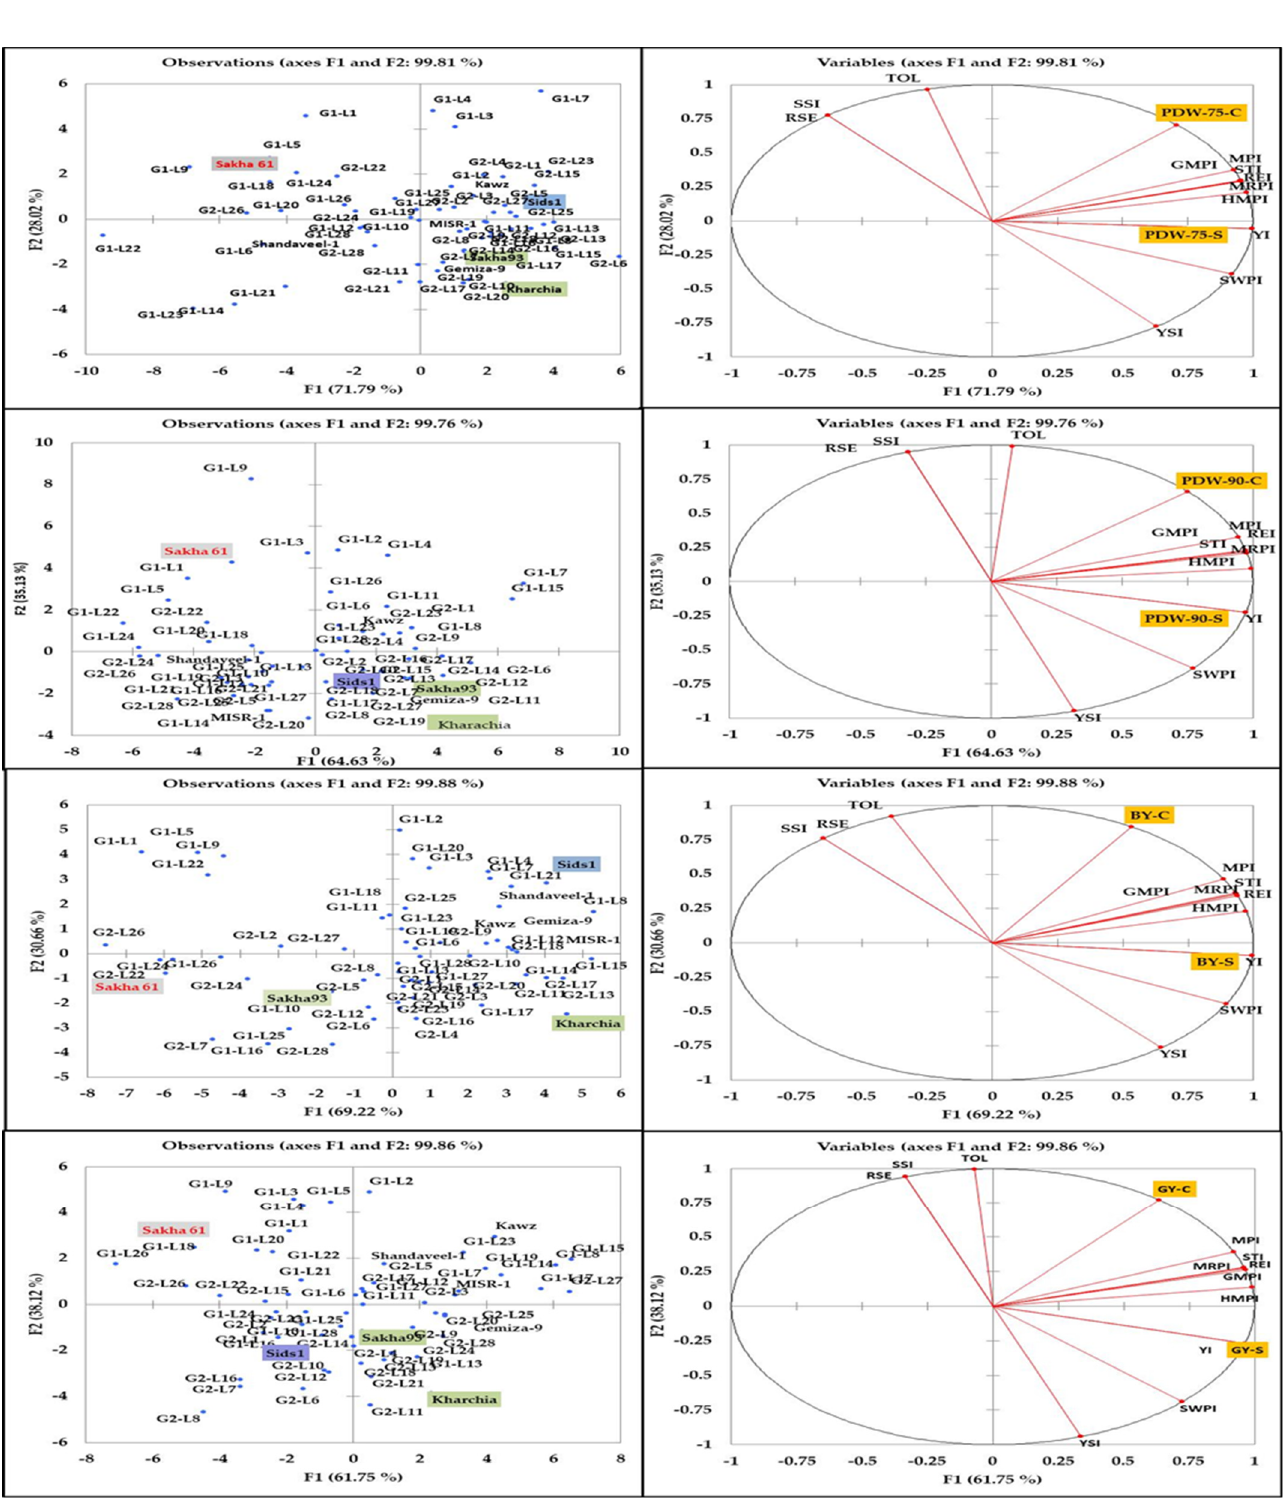
Figure 4. Principal component analysis plot showing the first two principal components (PCs) for plant dry weight measured at 75 days after sowing (PDW ‐ 75), plant dry weight measured at 90 days after sowing (PDW ‐ 90), biological yield (BY), and grain yield (GY) of 64 wheat genotypes grown under the control (C) and salinity stress (S) conditions. The full names of the different STIs are listed in Table 1.